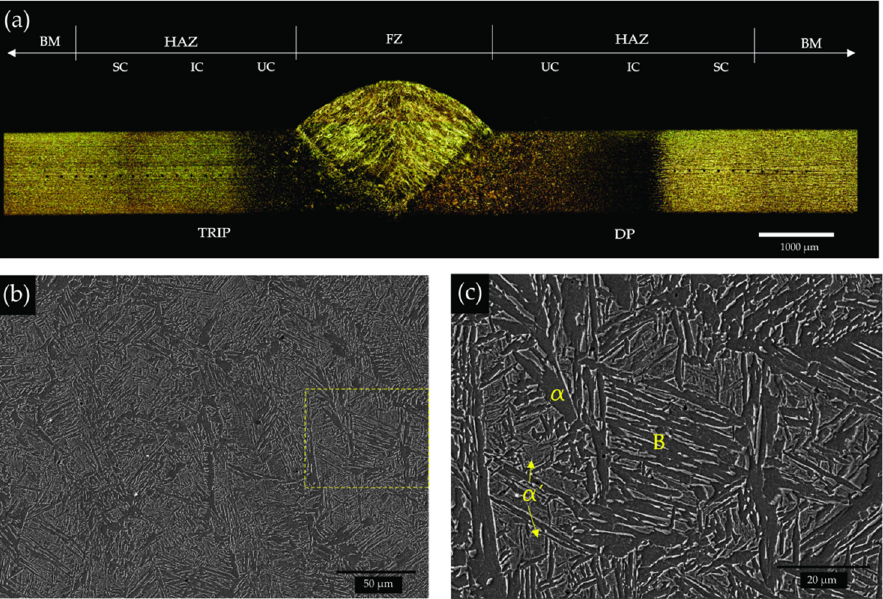
Figure 4. ( a )Macrostructure of the GMAW specimen showing the various zones along the weldment, ( b ) fusion zone (FZ) microstructure, ( c ) detailed FZ microstructure.